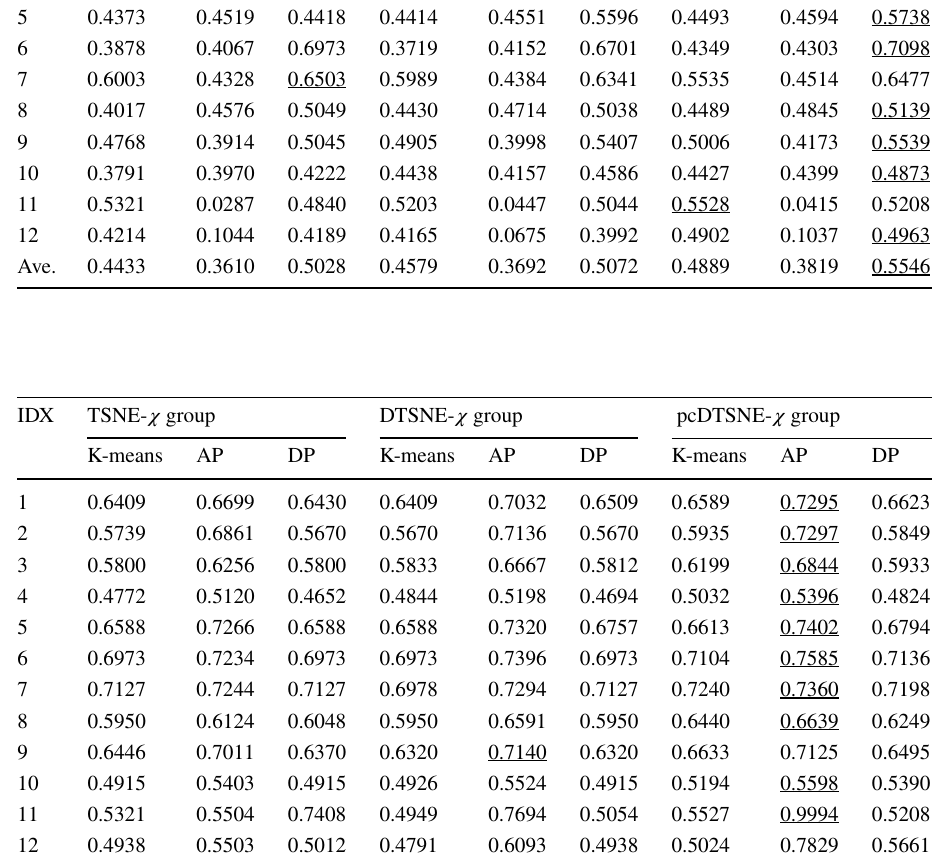
Table 2 Performance (accuracy) comparison of TSNE- 𝜒 group, DTSNE- 𝜒 group and pcDTSNE- 𝜒 group for clustering task over twelve datasets, and the highest score for each datasets among three type algorithms is denoted by underline font